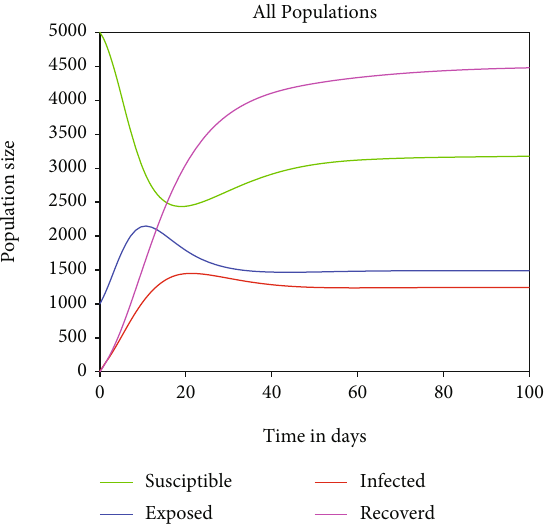
Figure 4: Solutions of the COVID-19 only model with parameter values Λ = 500 , β 2 = 0 : 41659 , μ = 0 : 0477 , φ = 0 : 096 , δ C = 0 : 0023 ψ = 0 : 0650 , ω = 0 : 09 , and its basic reproduction number R C 3 : 2707 > 1